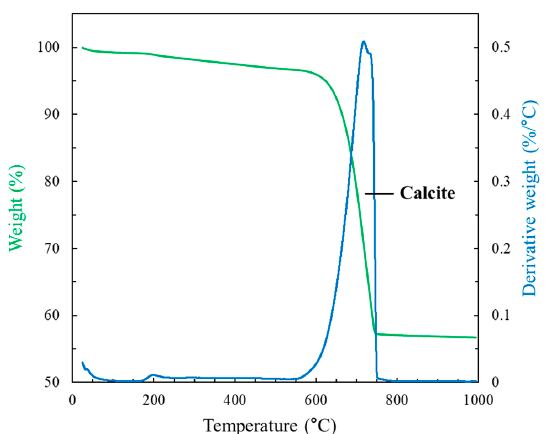
Figure 2. TGA/DSC result for a bulk oyster shell waste.